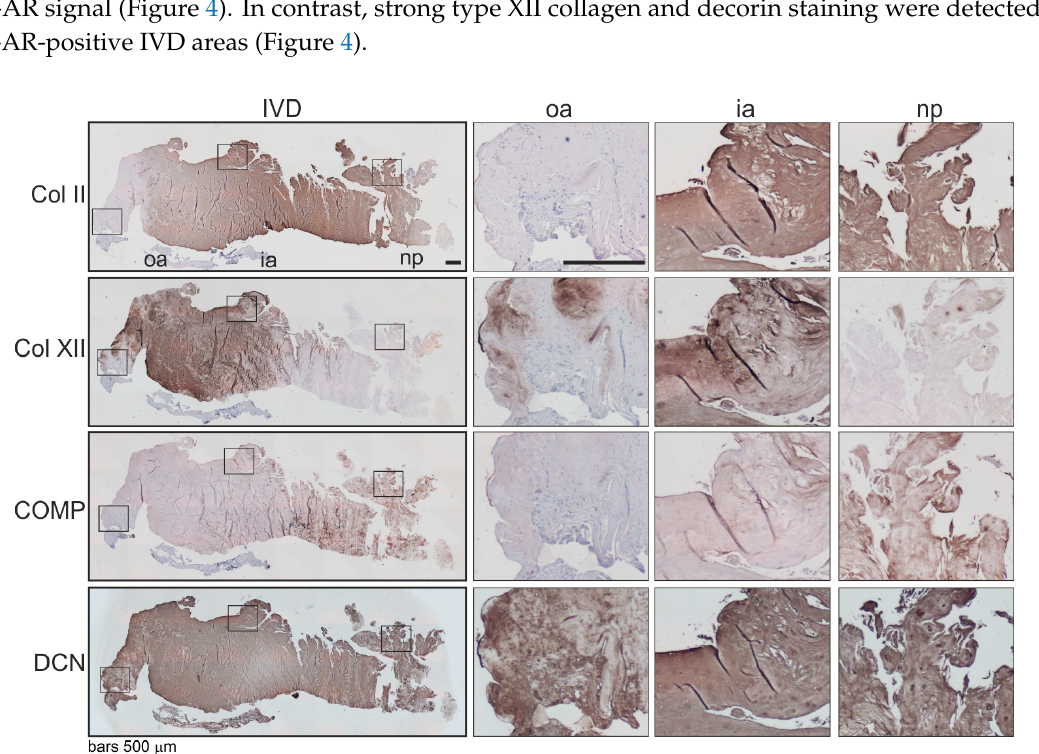
Figure 4. Localization and distribution of ECM proteins in human IVD tissue. (A) Immunohistochemical analysis of type II collagen (Col II), type XII collagen (Col XII), cartilage oligomeric matrix protein (COMP) as well as decorin (DCN) in human IVD sections (bars 500 μ m). Squares in the left panel represent further magnified regions shown to the right ( n = 3). Abbreviations: